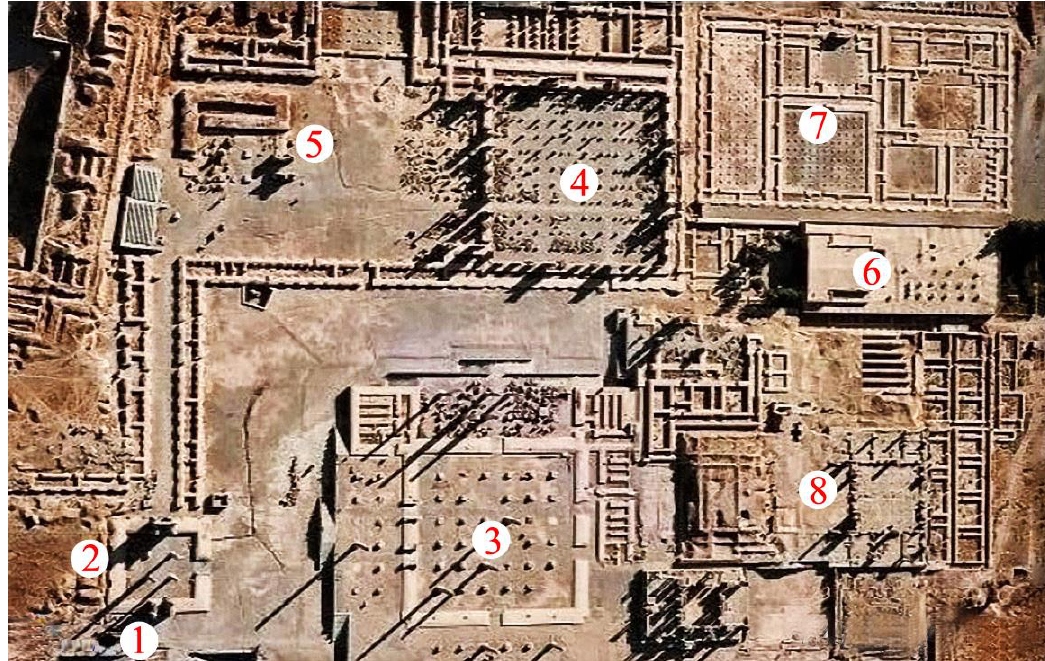
Figure 1. Aerial photography from the site. (1) The Terrace Stairway and entrance to the site; (2) the Gate of All Nations; (3) Apadana; (4) Hall of Hundred Columns; (5) Unfinished Gate; (6) Residential Palace of the Queen; (7) Treasury; and (8) Throne Hall of the King.